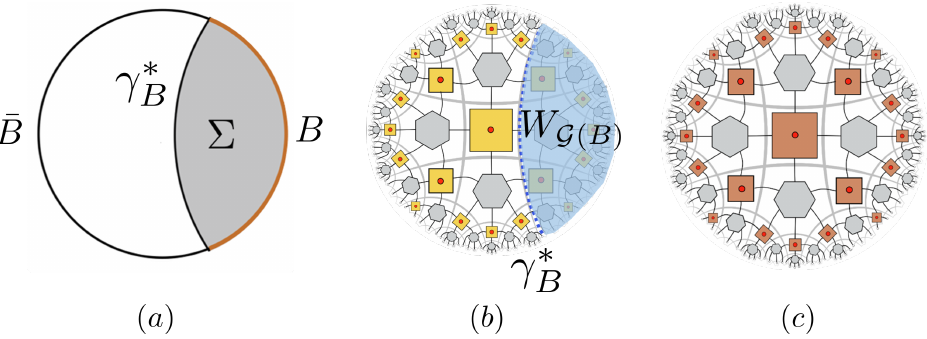
Figure 4. ( a ) A time slice of AdS. Shaded region represents an entanglement wedge of B . The bulk or encoded degrees of freedom in the entanglement wedge of B can be recovered from B . ( b ) An analogous picture of ( a ) in terms of a holographic tensor network, which is a graphical representation of an encoding map. The shaded entanglement wedge of B can be similarly defined through decoding operations. A “geodesic” γ ∗ is defined as the boundary of that wedge. ( c ) A “noisy” version of the B holographic code to the left, where each of the 4-qubit codes that made up of the tensor network are replaced by the skewed, approximate QECC